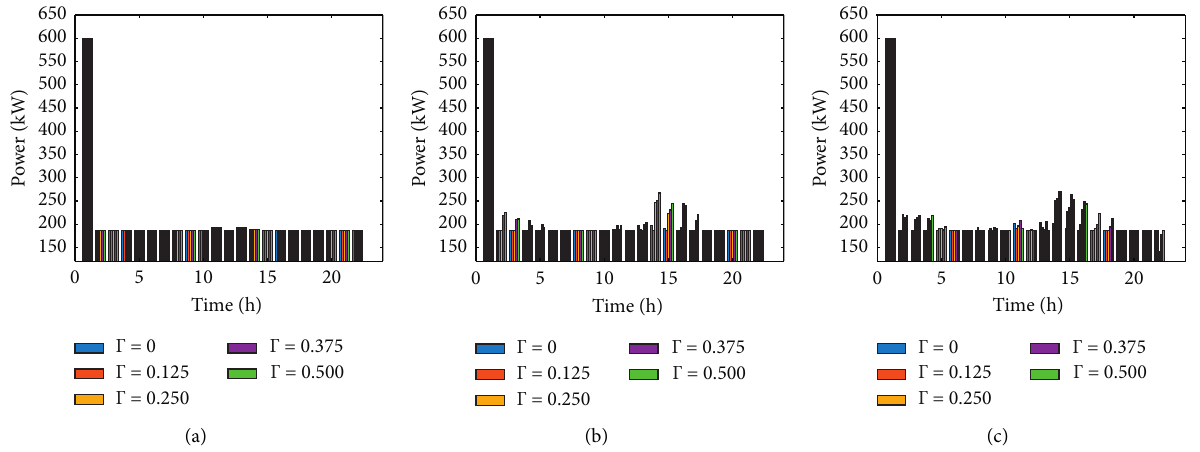
Figure 6: Comparison of the output of DGs between the RMPC method and the traditional MPC. (a) WI1 � 0.0. (b) WI2 � 2.5%. (c) WI3 � 5.0%.